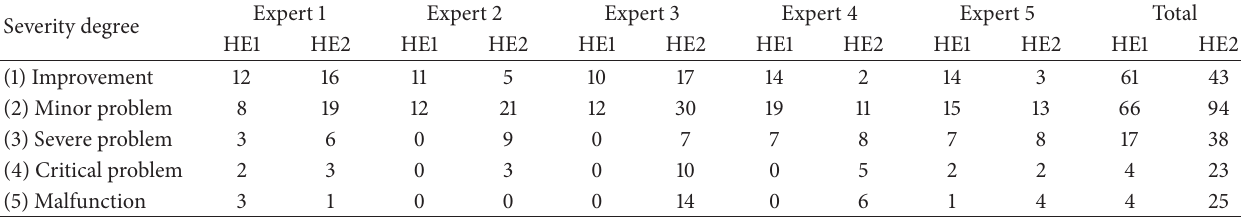
Table 4: Distribution of usability violations on Rolf Molich’s severity rating scale [29].